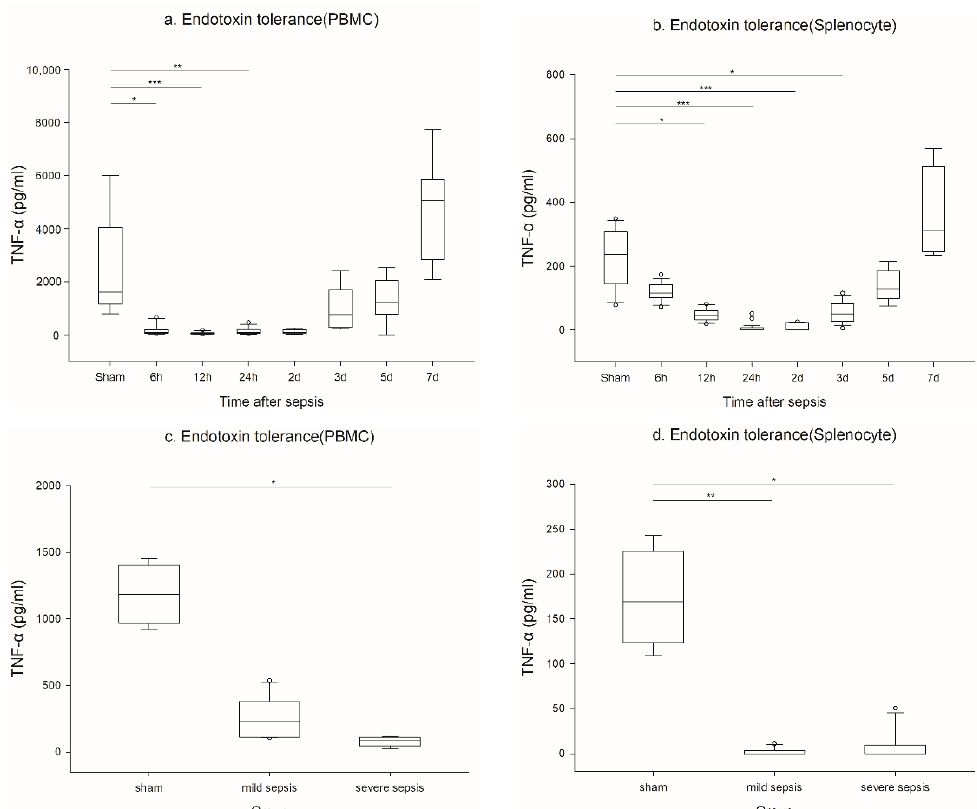
Figure 2. Serial change of endotoxin tolerance in PBMCs and splenocytes: ( a ) Endotoxin tolerance in PBMCs (sham n = 9, 6 and 12 h n = 11, 24 h n = 12, 2 D n = 5, 3, 5, and 7 D n = 6); ( b ) endotoxin tolerance in splenocytes (sham, 2 D n = 11, 6 h n = 18, 12 h n = 12, 24 h n = 29, 3 D n = 16, 5 and 7 D n = 6); ( c ) endotoxin tolerance in PBMCs in mild and severe sepsis models (sham n = 4, mild n = 10, and severe n = 7); ( d ) endotoxin tolerance in splenocytes in mild and severe sepsis models (sham n = 4, mild and severe n = 12). *** p < 0.001, ** p < 0.01, and * p < 0.05 compared with the sham group. PBMCs: Peripheral blood mononuclear cells.